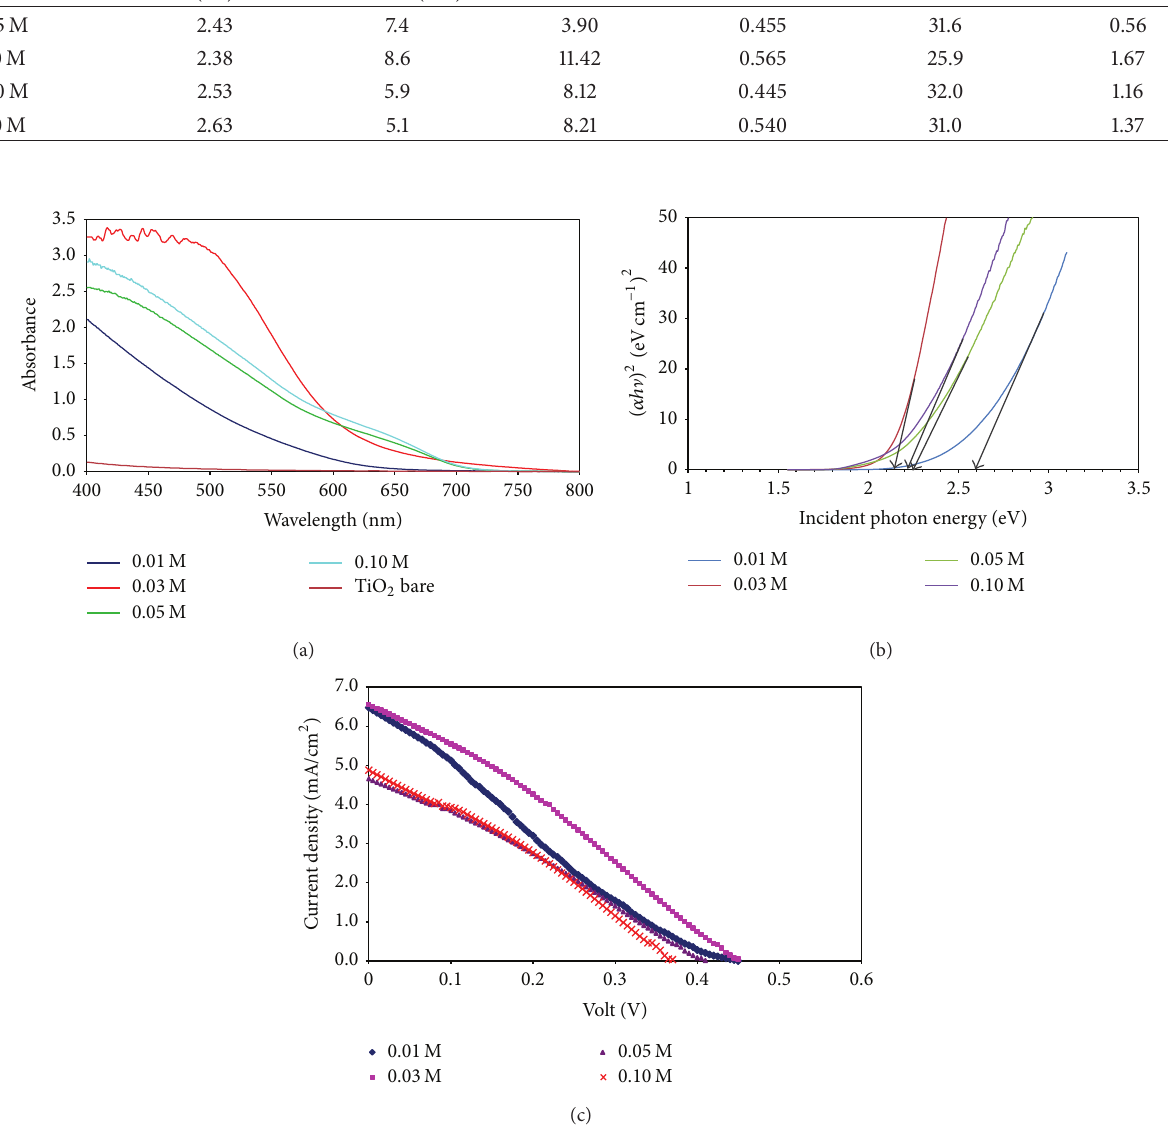
Figure 3: (a) UV-vis spectra, (b) Tauc plot, and (c) J-V curves of QDSSCs for CdSe QDs prepared using different precursor